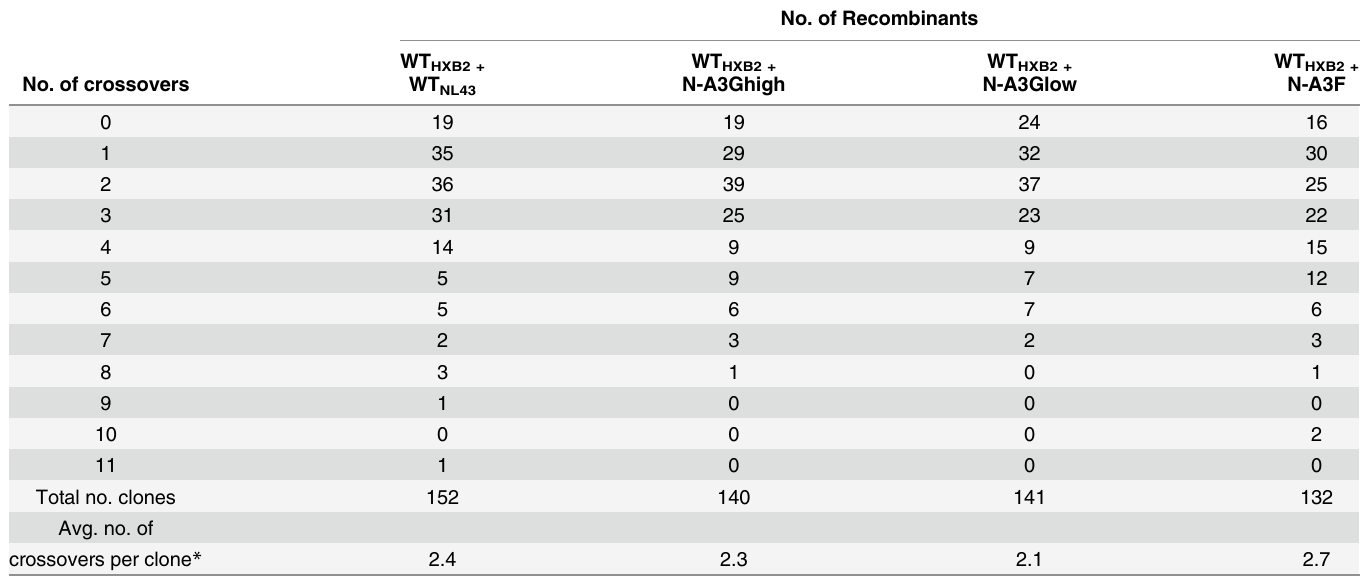
Table 1. Distribution and average number of crossovers in pol observed in recombinants.